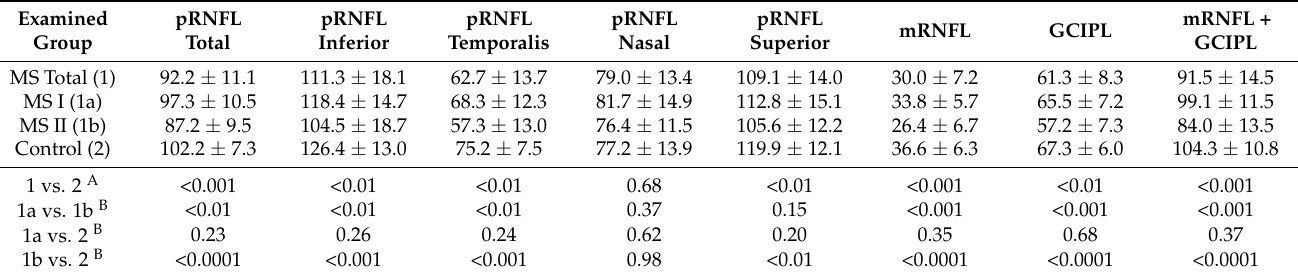
Table 3. OCT results in the examined groups.